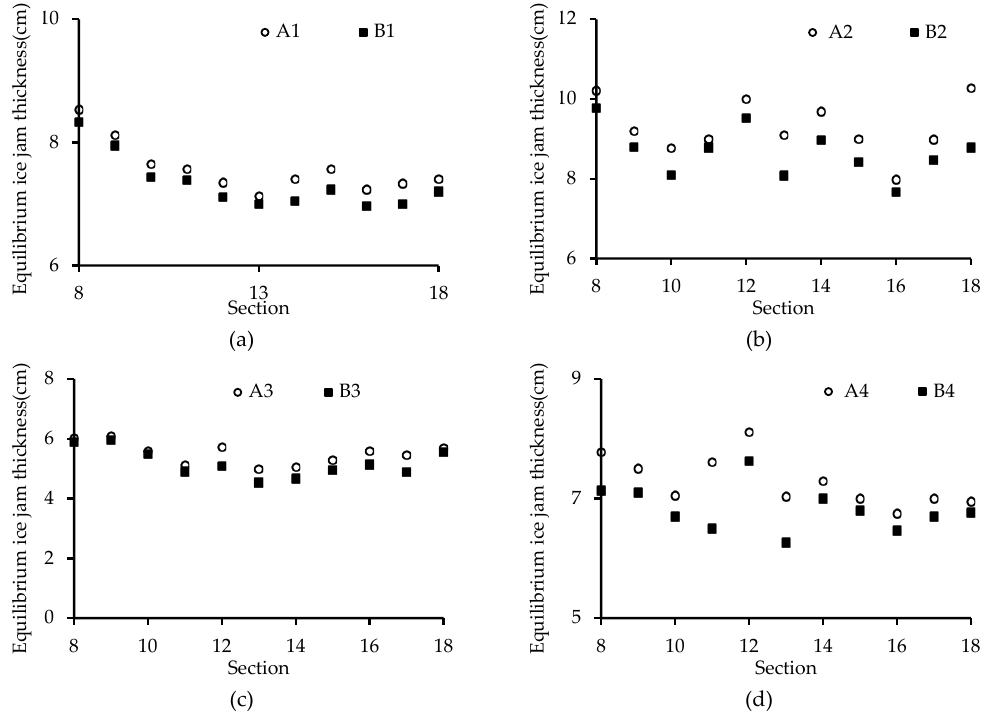
Figure 10. Comparison of the thickness of an equilibrium ice jam with the presence of a local scour at the pier to that without a local scour. (( a ): H 0 = 0.25 m, V 0 = 0.17 m/s; ( b ): H 0 = 0.25 m, V 0 = 0.15 m/s;